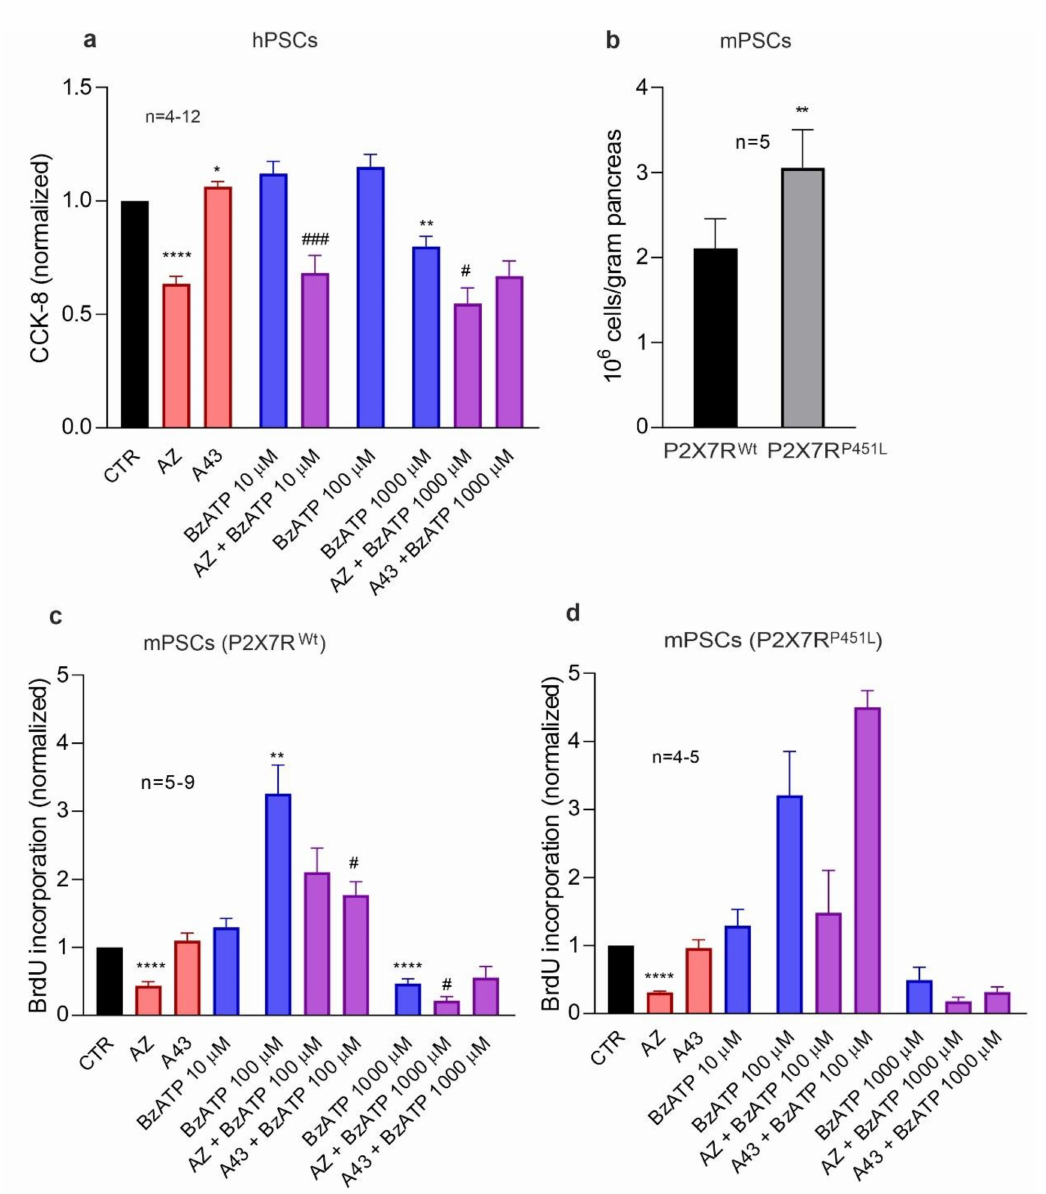
Figure 2. Role of P2X7R in cell proliferation in ( a ) hPSCs and mPSCs from ( c ) P2X7R wt and ( d ) P2X7R P451L mice. Cells were treated with different concentrations of the agonist BzATP (0, 10, 100, 1000 µ M) with/without 10 µ M inhibitor AZ10606120 (AZ) or A438079 (A43) in 1% FBS. Data are normalized to the control value (CTR). We performed one-sample t -test followed by Bonferroni correction and significance compared to the control is indicated as follows: * p < 0.05, ** p < 0.01, **** p < 0.0001. Comparisons between agonist and agonist + inhibitor have been evaluated with t -test and significance is indicated by # p < 0.05, ### p < 0.001. ( b ) Number of PSCs isolated from the pancreas of either P2X7R wt or P2X7R P451L mice, p =